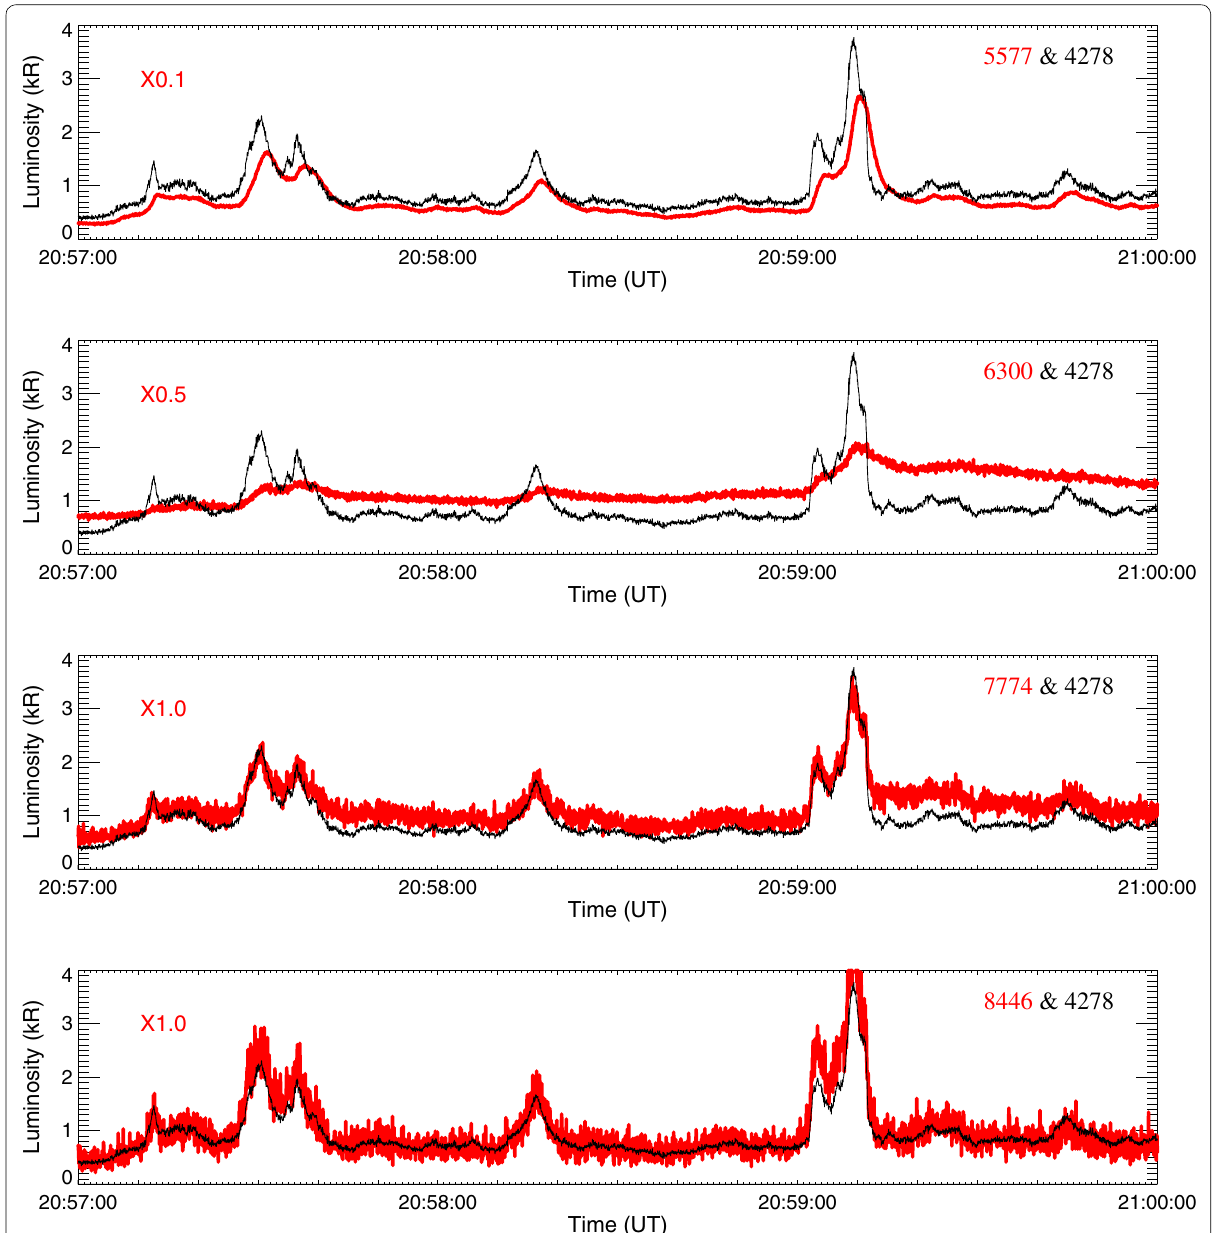
Fig. 9 This figure is the same as Fig. 7 except for the interval between 20:57:00 and 21:00:00 UT on October 19, 2017, and multiplied factors of 0.1, 0.5, 1, and 1 for the emissions of 557.7 nm, 630 nm, 777.4 nm, and 844.6 nm,